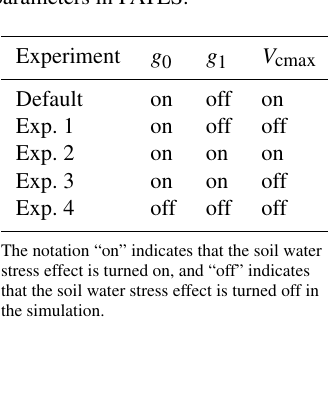
Table 2. Model simulations for studying soil water stress effects on physiological parameters in